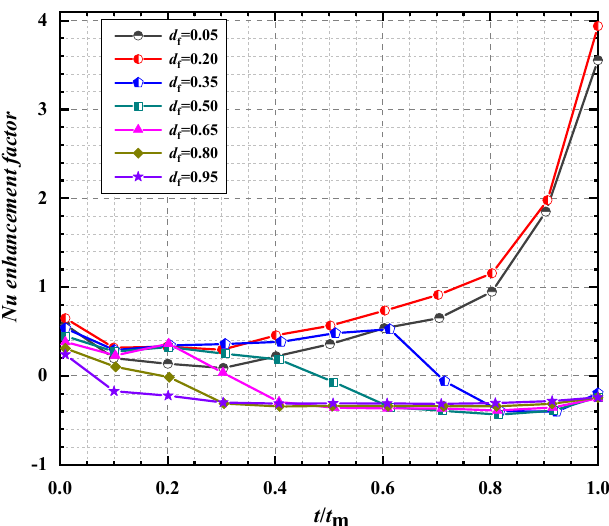
Figure 9. Variation of ε Nu with t/t m for different d f .